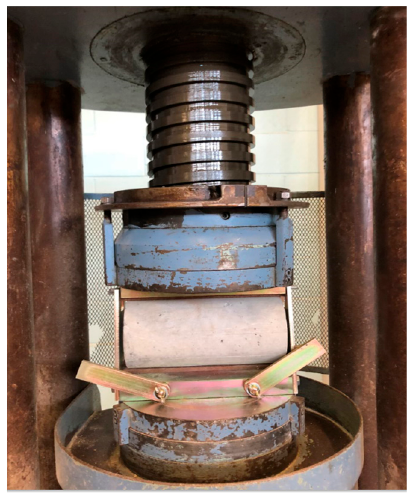
Figure 6. Splitting tensile test.